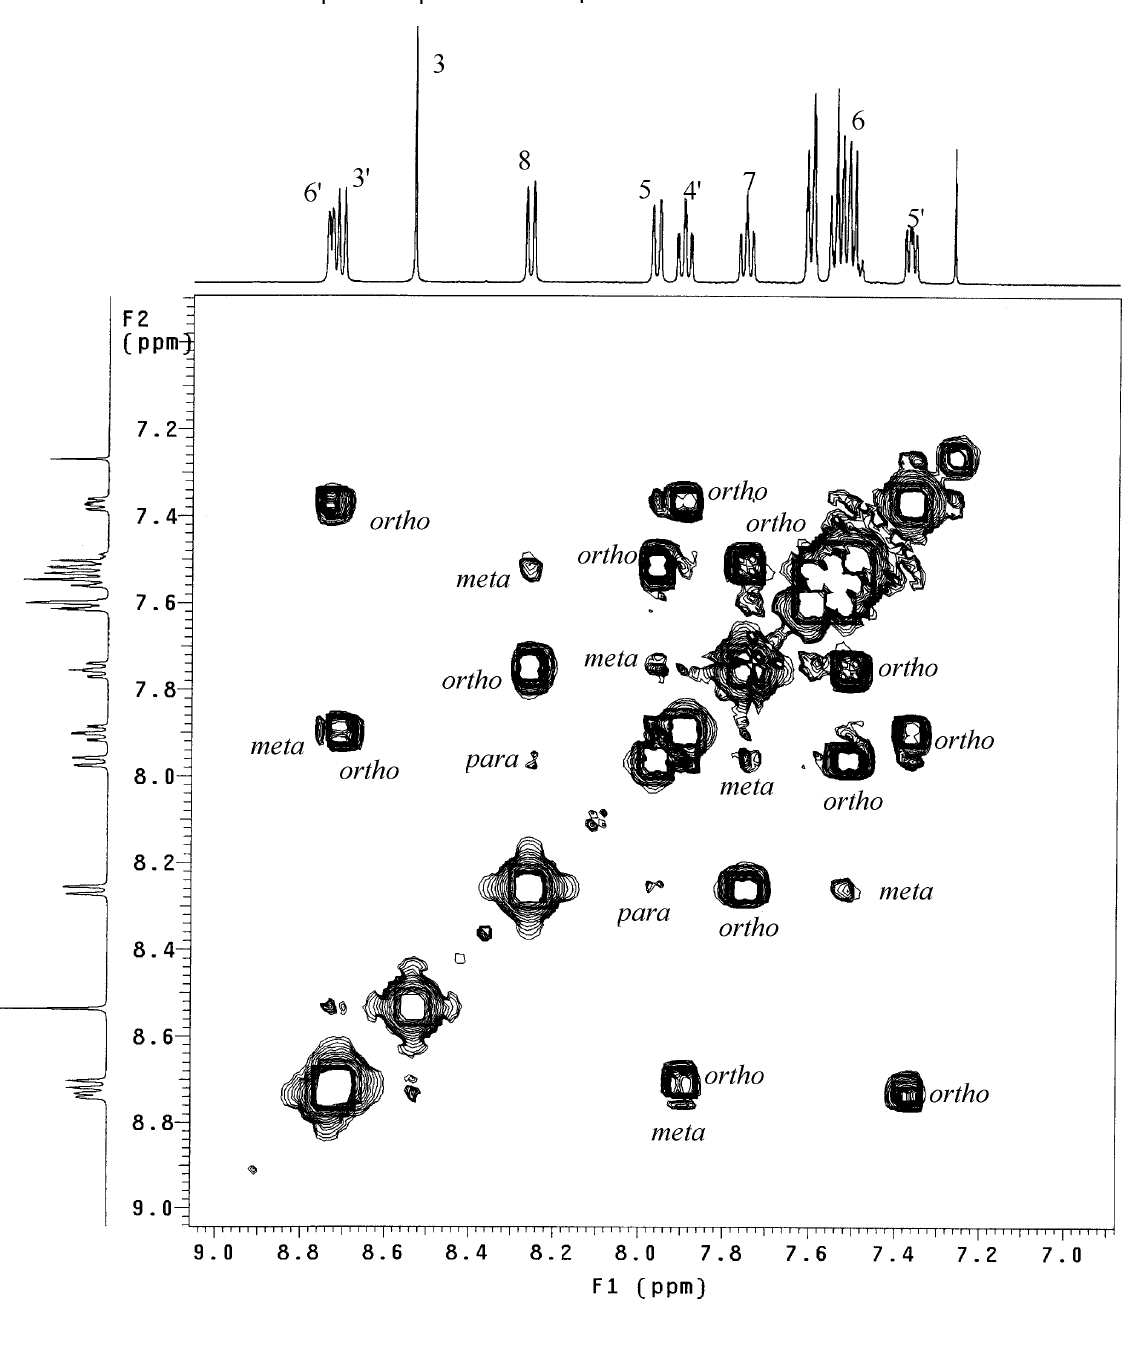
Figure 1: 500 MHz 1 H/H 1 COSY-45 spectrum of L and left traces are 1D proton spectrum of L